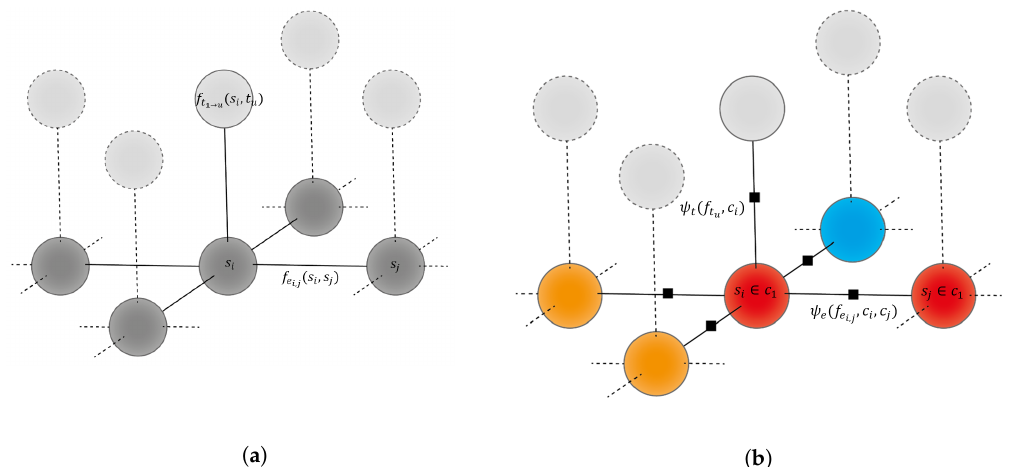
Figure 4. Illustration of the clustering using conditional random fields within a connected component graph: Given the seeds t 1 → u from the region growing, one of u labels is computed for each s given the factor graph with the edge and node potentials. ( a ) Representation of the unary and pairwise features and ( b ) the representation of the factor graph. Decoding results in the assignment of both s i and s j to c 1 (red